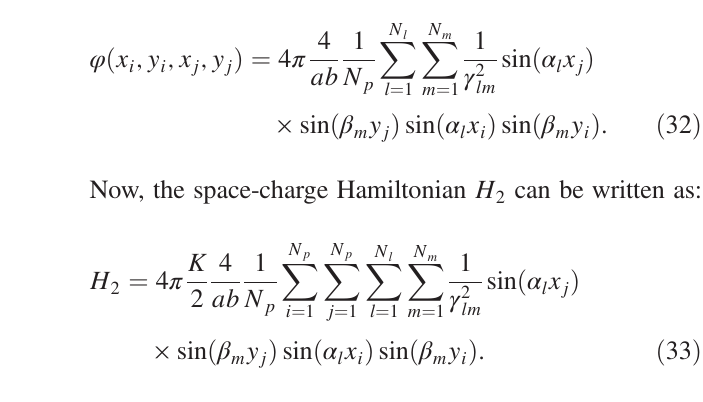
FIG. 1. Charge density distribution along the x axis.